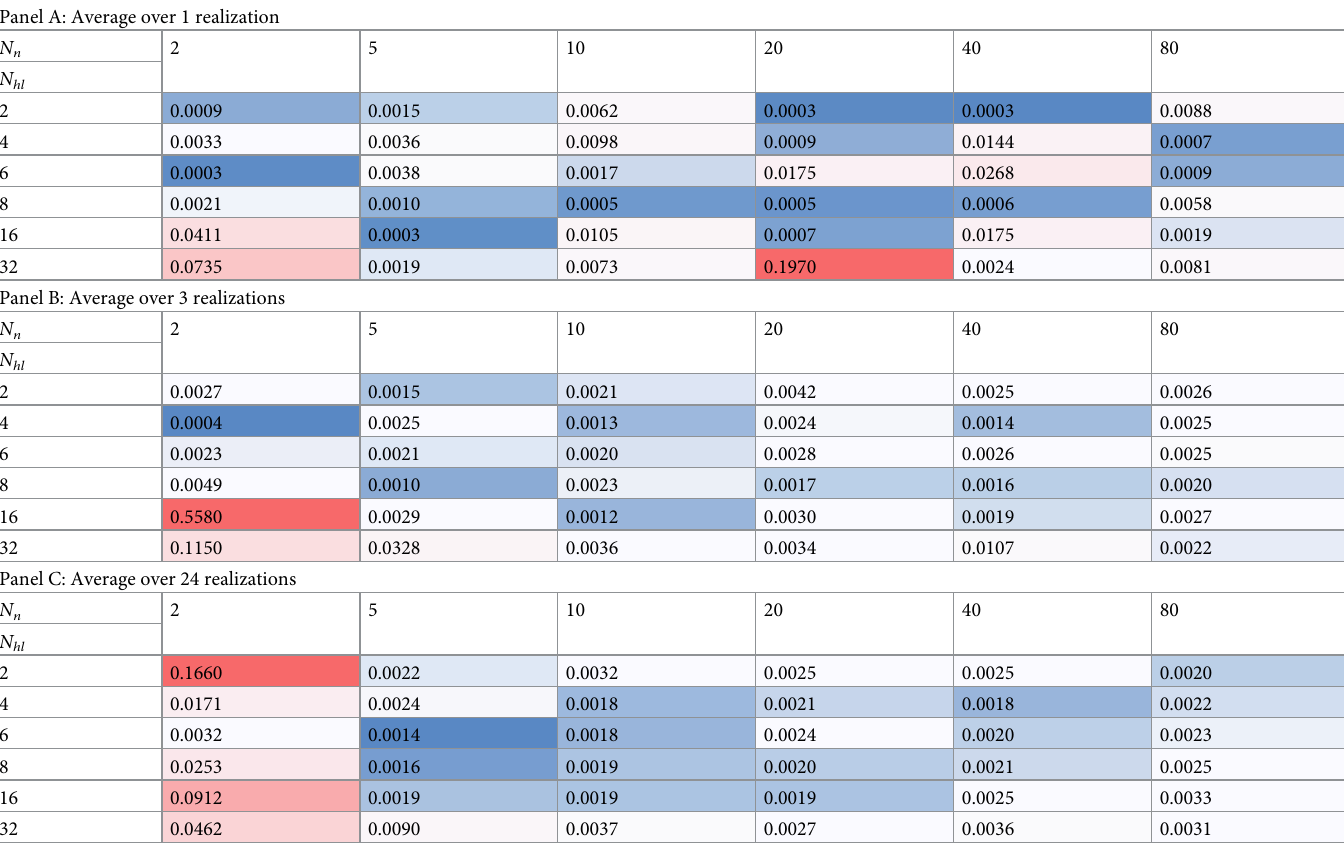
Table 2. Diffusivity equation—forward modeling: PINN performance as function of hyperparameters. Relative L 2 errors between the exact and predicted values of p for the validation set. The table shows the dependency on the different number of hidden layers N hl and different number of neurons per layer N n . Here, the total number of training and collocation points is fixed to N = 96 and N P = 160, b